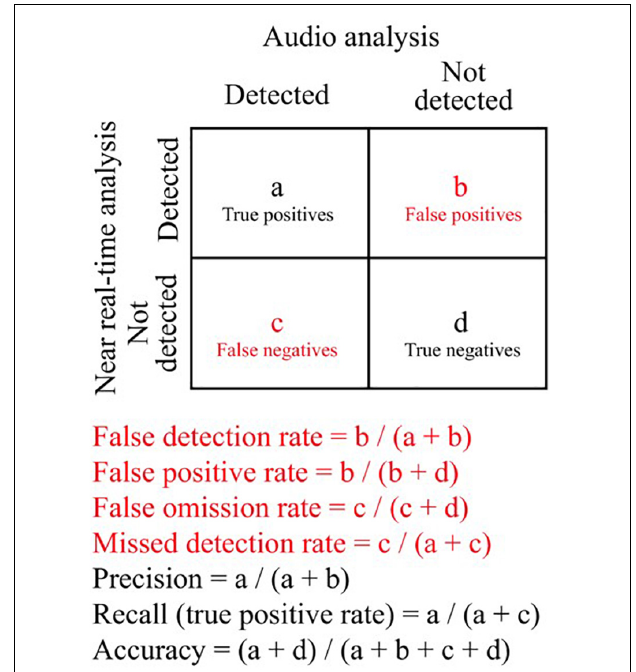
FIGURE 6 | Definitions of performance metrics for comparing occurrence estimates from the near real–time and audio analyses. A good detection process minimizes the quantities in red and maximizes the quantities in black. Replicate of Figure 4 in Baumgartner et al.